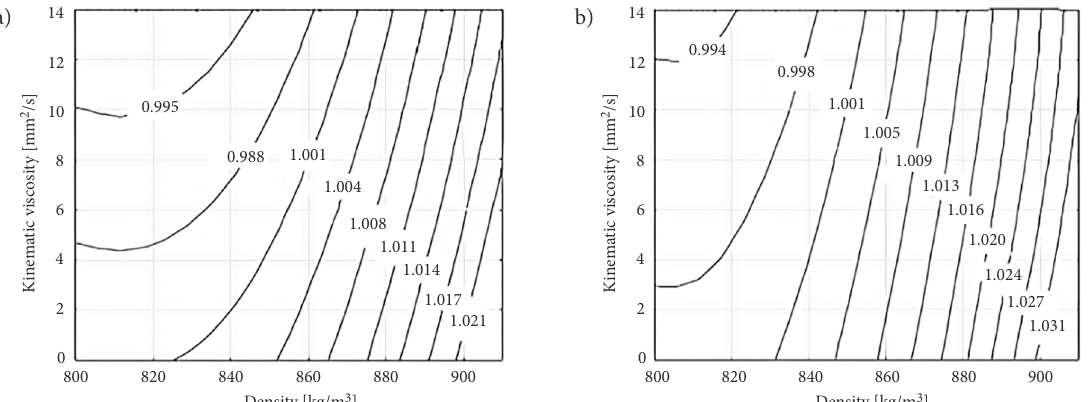
Figure 13. Multivariate characteristics of relative BSFC change in MTU 8V 396TB engine: a – full load; b – partial